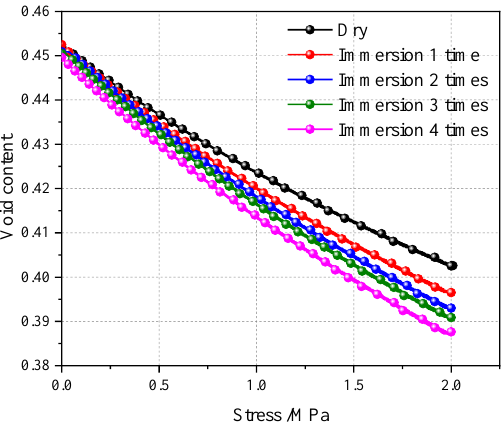
Figure 15. Void stress curve of the gangue with different immersion times.